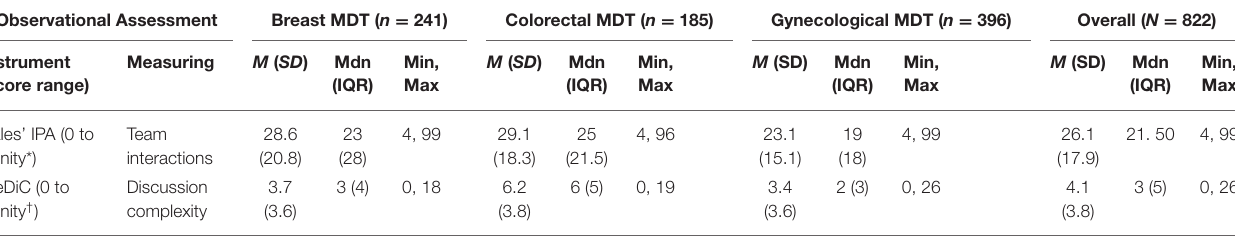
TABLE 3 | Descriptive statistics for the composite scores of the Measure of case-Discussion Complexity (MeDiC) and Bales Interaction Process Analysis (Bales’ IPA). Observational Assessment Instrument Measuring (score range) Bales’ IPA (0 to